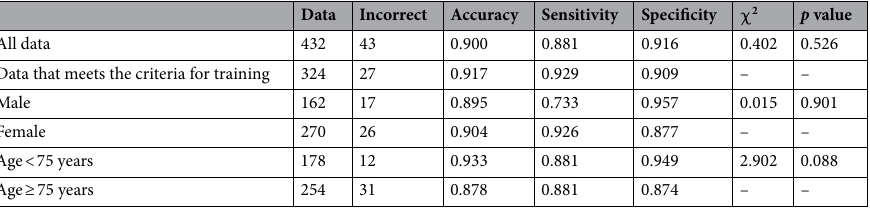
Table 2. Discrimination results between dementia and non-dementia groups using machine learning.